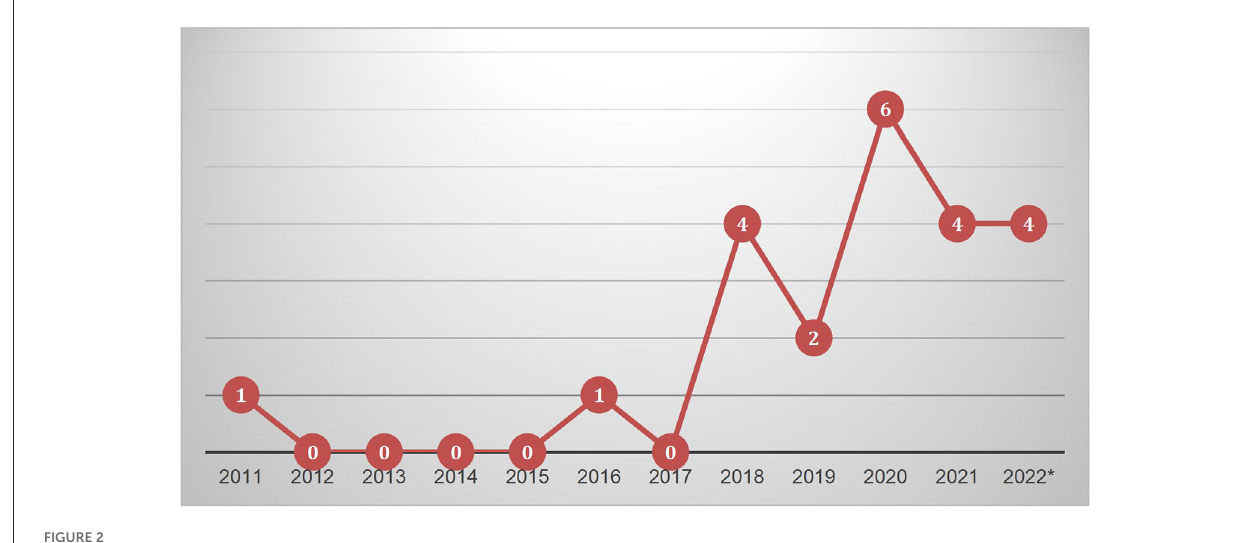
FIGURE2 Number of articles published by year.